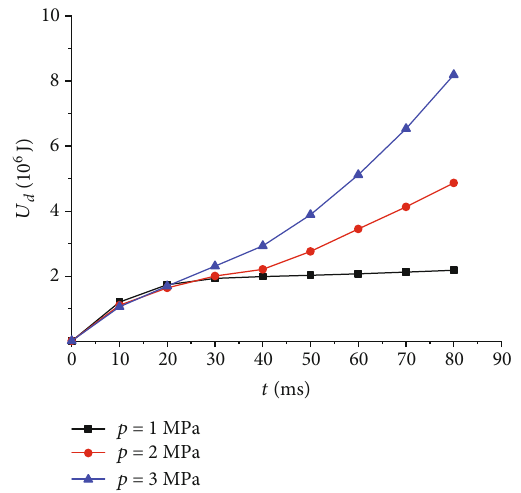
p = 1 , 2, d of the system with